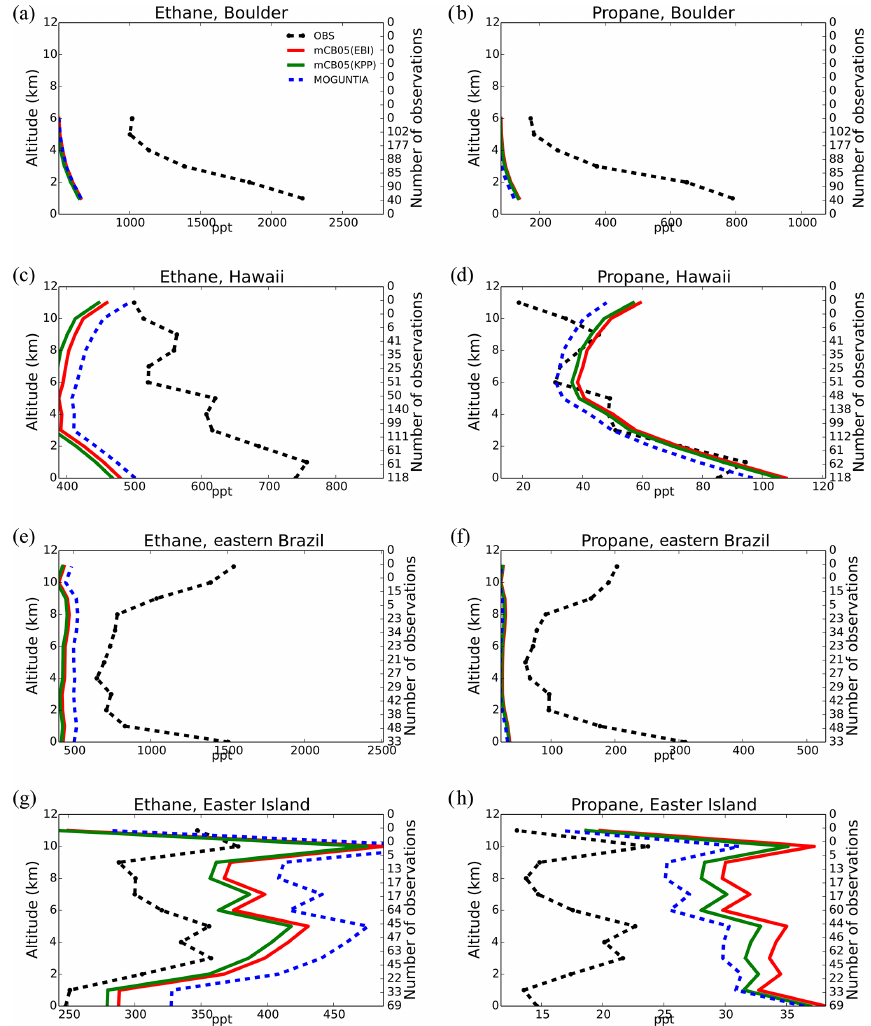
Figure 10. Comparison of TM5-MP vertical profiles (km) of C 2 H 6 (left column) and C 3 H 8 (right column) against aircraft observations (black line; ppt) for the two chemistry schemes, mCB05(KPP) (green line) and MOGUNTIA (blue line), using colocated model output for 2006 sampled at the measurement times; error bars indicate the standard deviation. For comparison, model results of mCB05 with the EBI solver (red line) are also presented. The numbers on the right vertical axis indicate the number of available measurements.